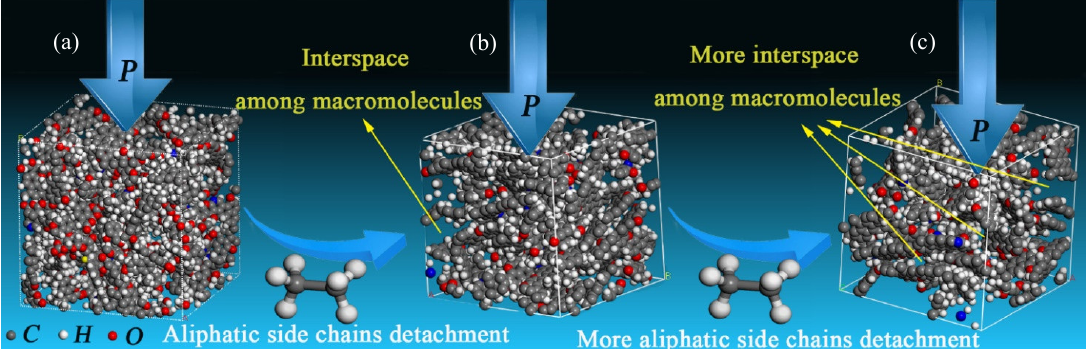
Figure 17. Sketch map of macromolecules with aliphatic side chains detaching in TDC (( a ) is unalerted coal; ( b ) is tectonically deformed coal; ( c ) is tectonically deformed coal with greater deformation degree than ( b )).